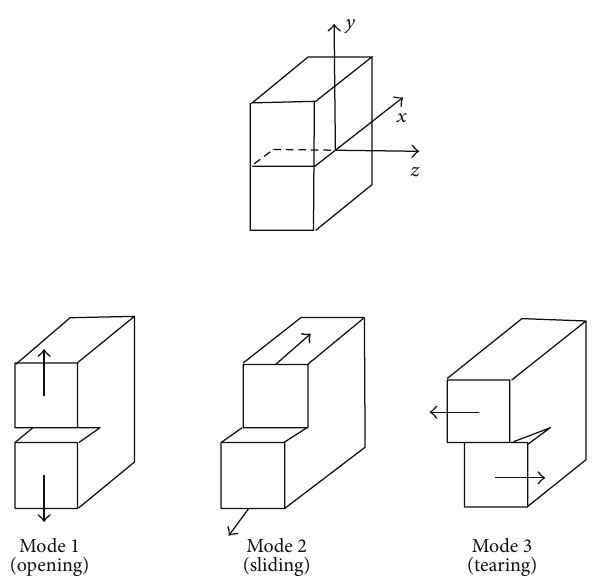
Figure 12: Modes of crack displacement